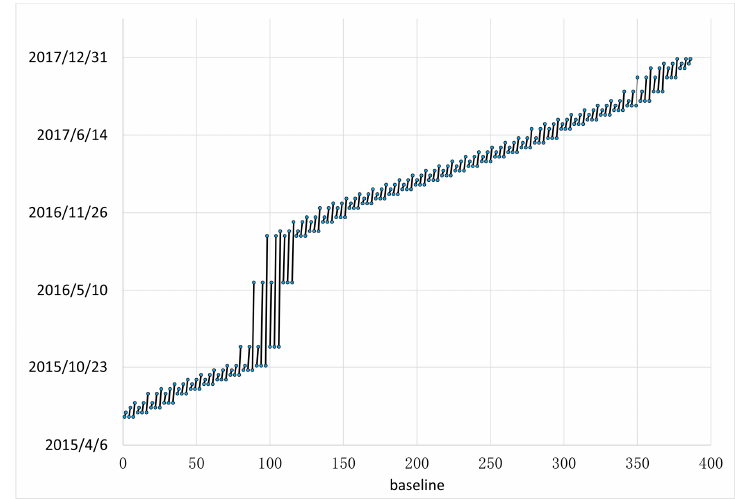
Fig 6 Figure 6. Condition of interferometric pairs. The black lines are interferometric pairs.